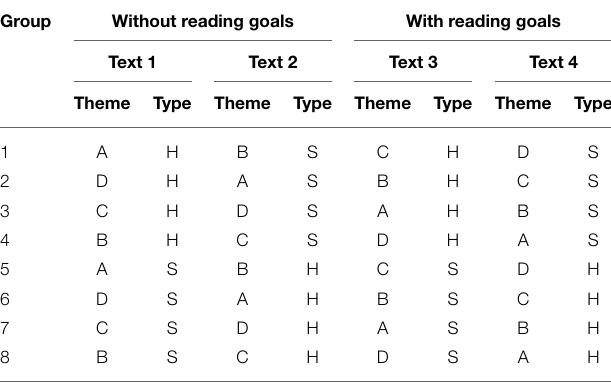
TABLE 1 | Reading order in the formal